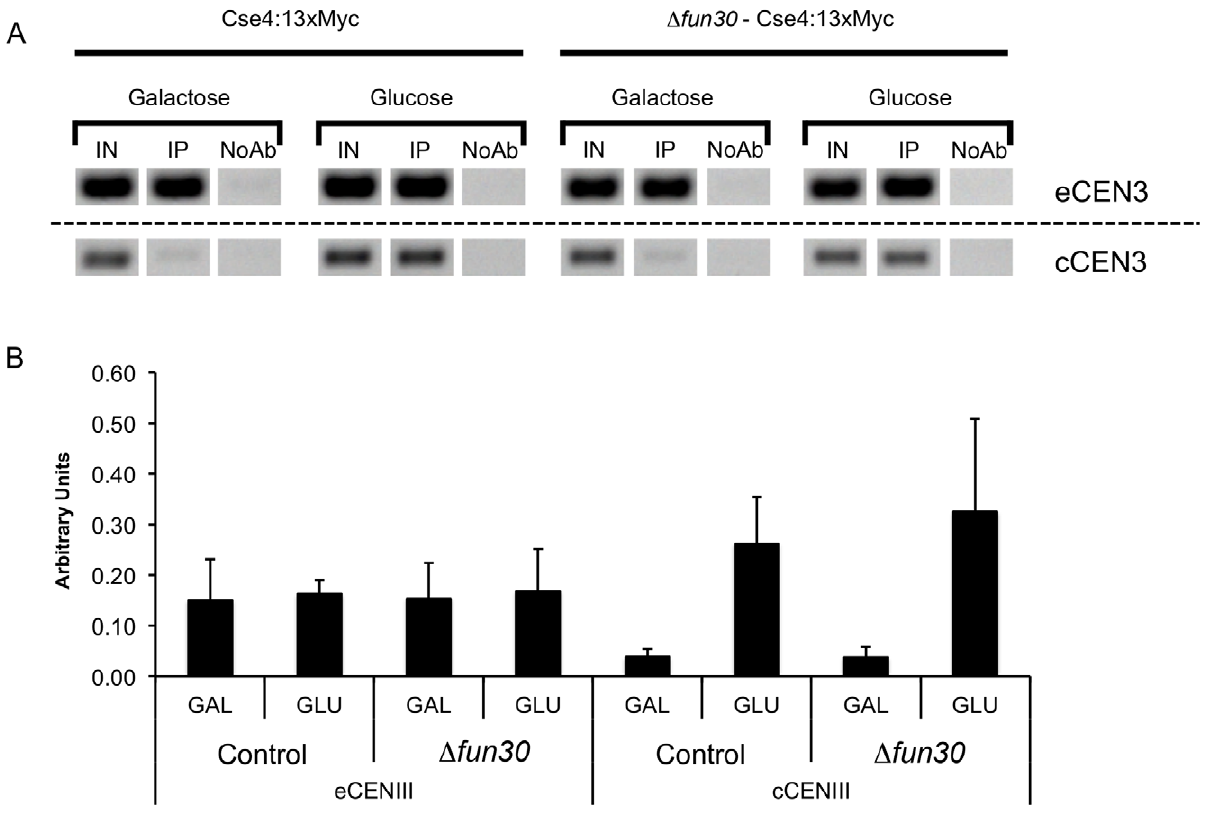
Figure 7. Deletion of FUN30 does not affect Cse4 occupancy at a constitutive and an induced centromere. A) Cse4 histone variant occupancy at the endogenous CEN3 locus (eCEN3) and at a conditional CEN3 locus (cCEN3) when it is repressed (in the presence of galactose) or induced (glucose) by ChIP. Control (SC138) and D fun30 (SC140) cells are grown in YP Gal until < 1 OD, then shifted in YP Glu or YP Gal containing 15 m g/ml of nocodazole and incubated for 4 hours. Cse4-Myc associated chromatin was immunoprecipitated and the immunoprecipitated DNA was analyzed by PCR followed by agarose gel electrophorsis and ethidium bromide staining to visualize the DNA fragments. PCR was with the primers described in Table 3. Shown are the relevant, cropped out bands from a single, representative gel, input was 1/243th of the immunoprecipitated material. B) A bar plot reporting the enrichment over the input, expressed in arbitrary units, of three independent experiments as shown in (A). Quantitation of bands was carried out using ImageJ software, error bars are standard deviation from the